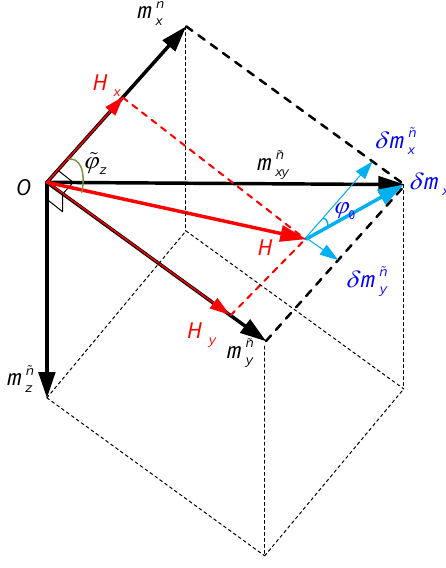
Figure 3. The geometric relation of earth magnetic field, magnetic disturbance and magnetometer magnetic (magnitude and direction of the magnetic field).